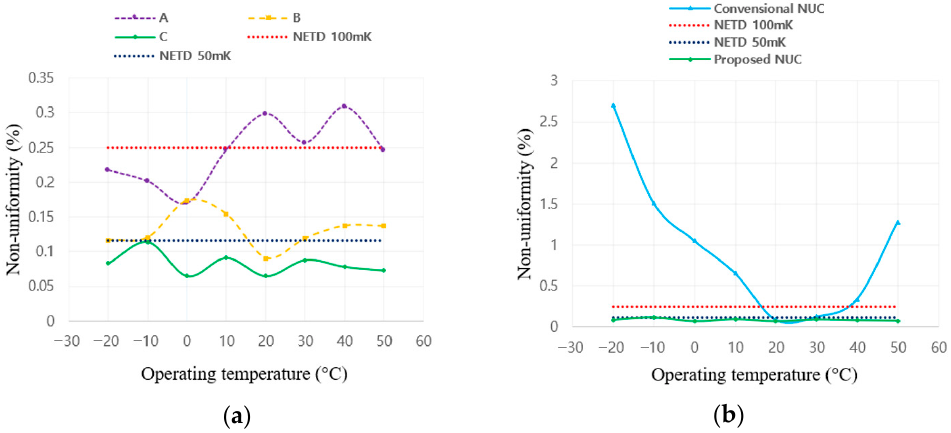
Figure 12. Non-uniformity according to operating temperature: ( a ) for the proposed NUC; ( b ) for the two methods using the ‘C’ switch. Table 2. β n and α n for the four bolometers shown in Figure 7.